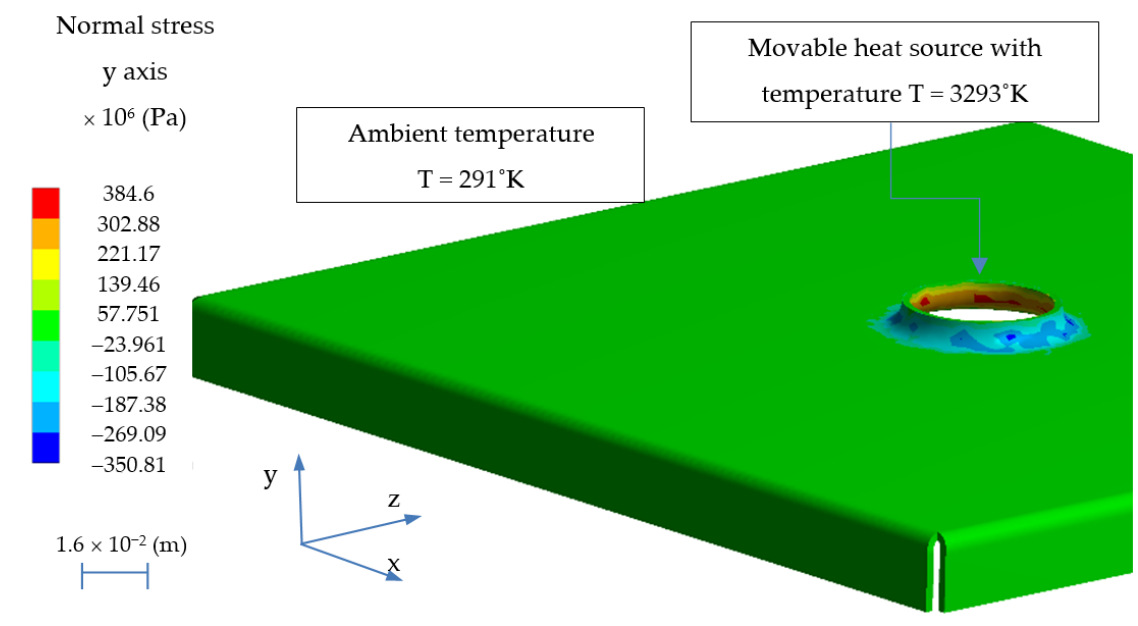
Figure 11. The state of normal stresses after the h6 flange extrusion process with thermal conditions originating from the welding process.